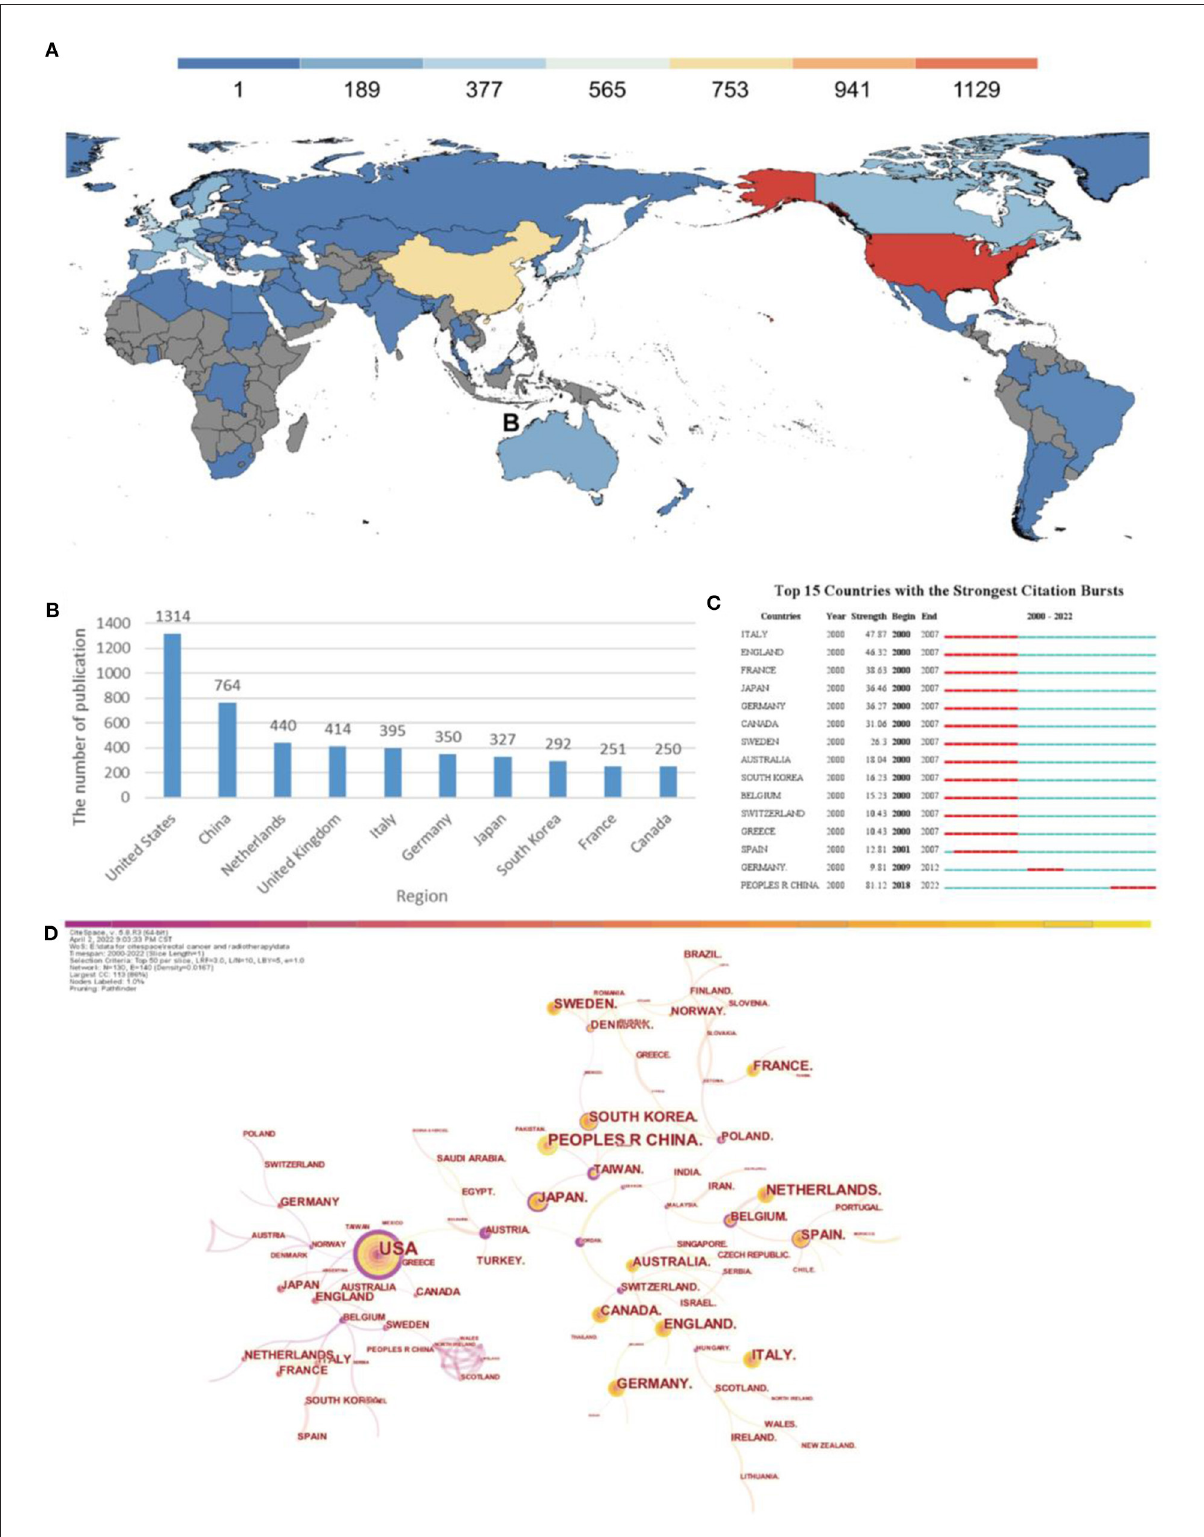
FIGURE2 Analysis of countries engaged in research on radiotherapy for rectal cancer. (A) Distribution of countries in terms of publications. (B) Top 10 most productive countries. (C) Top 15 countries in publishing research related to radiation therapy for rectal cancer with burst period after 2000. (D) Network diagram showing country links (Timespan: 2000–2022; Slice Length: 1; Selection Criteria: Top50 per slice; Network: N = 130, E = 140; Density: 0.0167; Largest CC:113; Nodes Labeled:1.0%; Pruning: